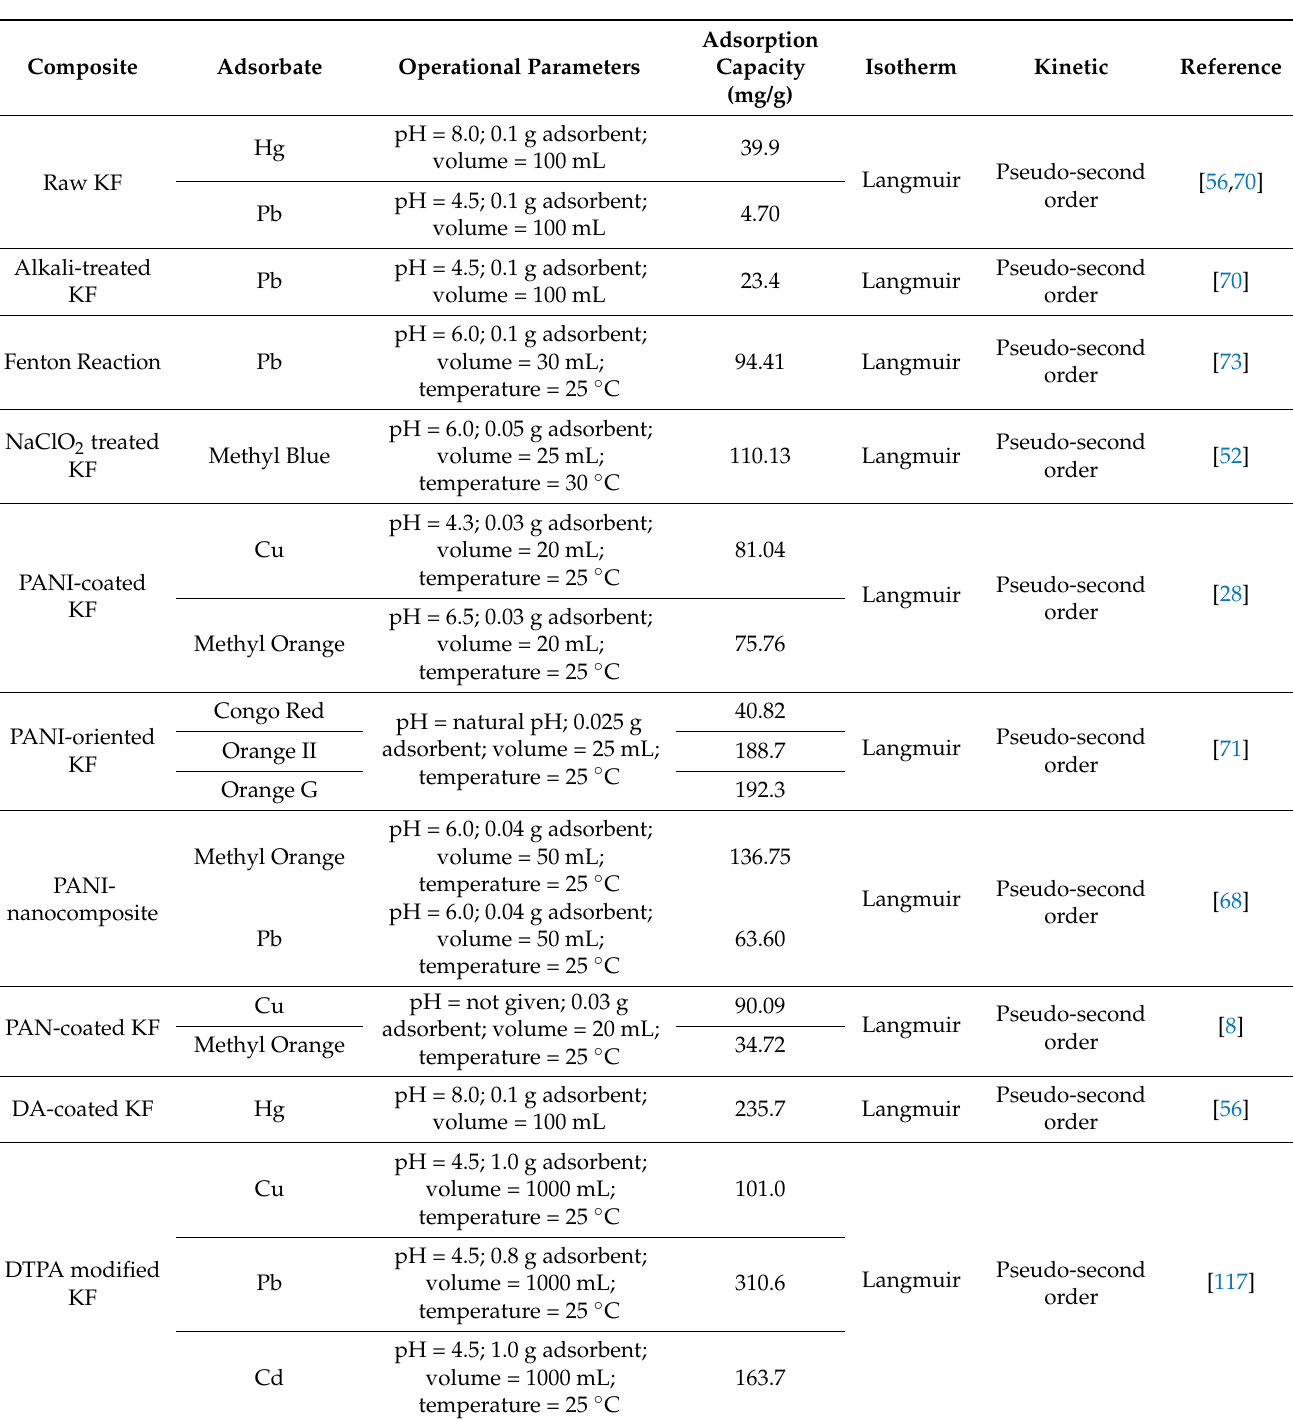
Table 1. Various adsorption capacity of heavy metals and dyes using KF and KF